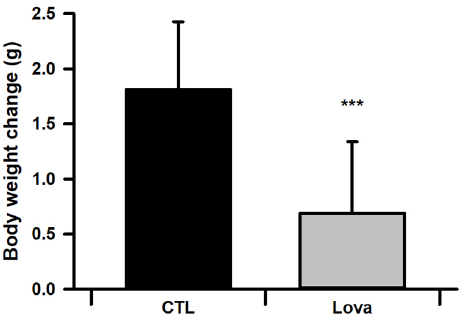
Figure 1. Average of body weight for control and lovastatin-treated mice from day 1 to 10 after Lovastatin injection ( n = 30, *** p < 0.001).